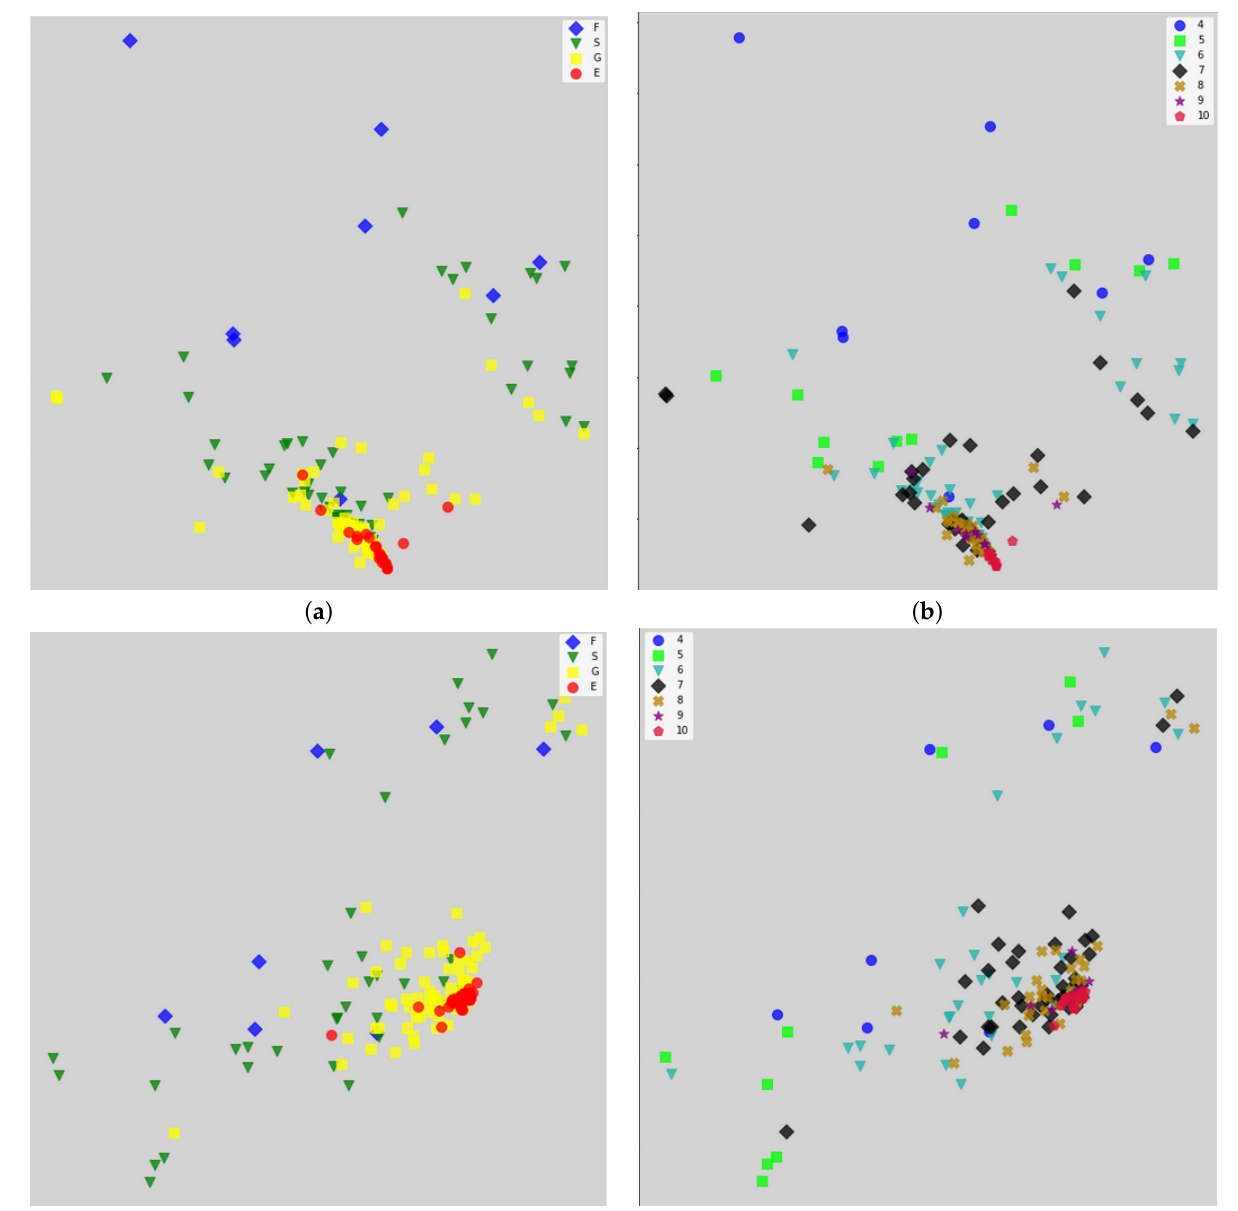
category ( a ) and grade -based classifications ( b ); t and the